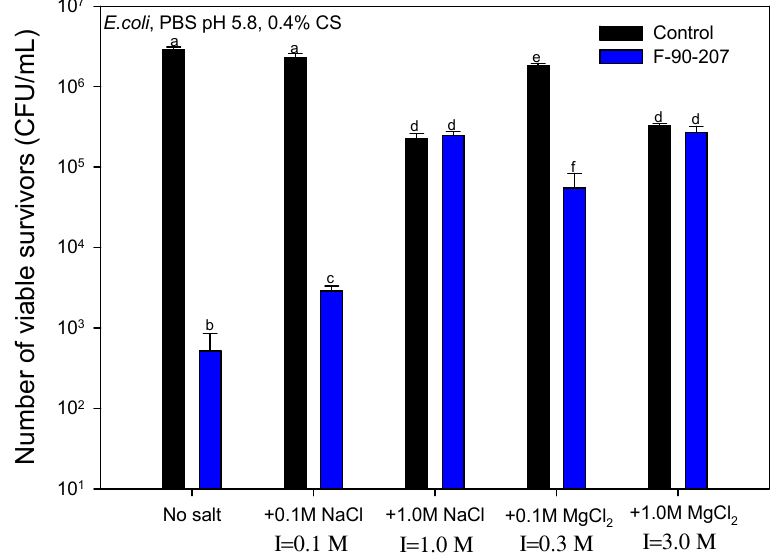
Figure 9. Effect of salt concentration and ionic strength (I) on the antibacterial activity of chitosan. Bars with different letters are significantly different ( p < 0.05). Sample is F-90-207 (flakes). The number of viable organisms was the same after 18 and 48 h incubation on the agar plates, suggesting that recovery from sub-lethal injury had not taken place. Means that do not share a letter are significantly different with a confidence level of 95% by Tukey pairwise comparisons.